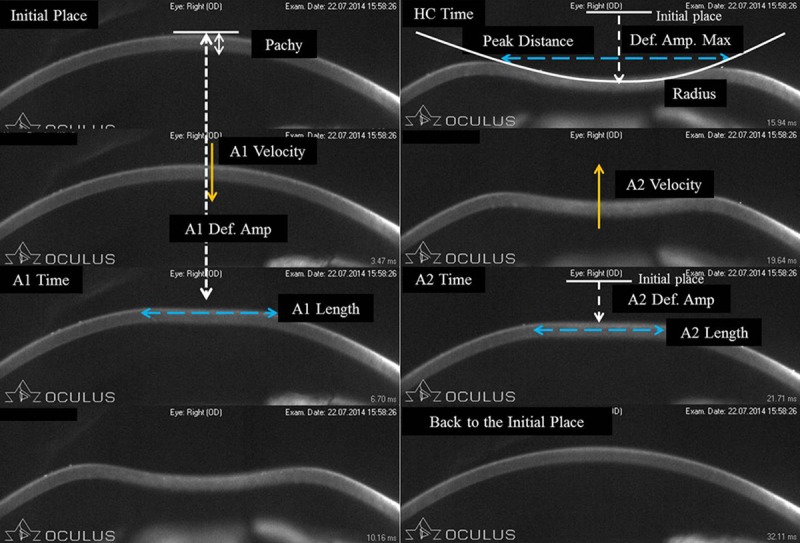
Corneal movements after an air puff from CST and obtained parameters.Pachy: central corneal thickness; A1/A2 Time: the durations of time taken from initiation of the air puff to first (when the cornea is moving inward) or second applanation (when the cornea moves outward); A1/A2 Length: the lengths of the flattened cornea at first and second applanations; A1/A2 Velocity: the corneal velocities during first and second applanations; HC Time: the length of time from the initiation of the deformation to the point when the cornea reaches highest concavity; Radius: the central curvature radius at the highest concavity; Peak Distance: the distance between the two surrounding peaks of the cornea at the highest concavity; A1 Def. Amp: the moving distance of the corneal apex from the initial position to that at the A1 Time; A2 Def. Amp: the moving distance of the corneal apex from the initial position to that at A2 Time; Def. Amp. Max: the distance of the corneal apex movement from the initiation of the deformation to the highest concavity.